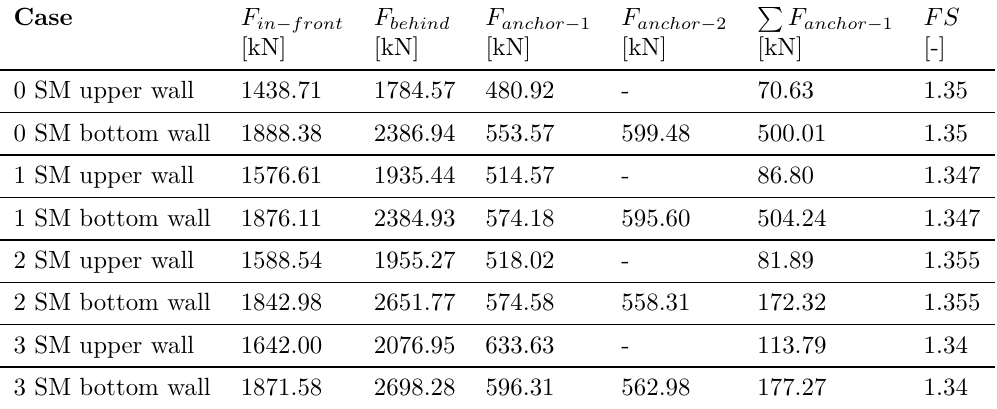
Table 3. Results of FEM